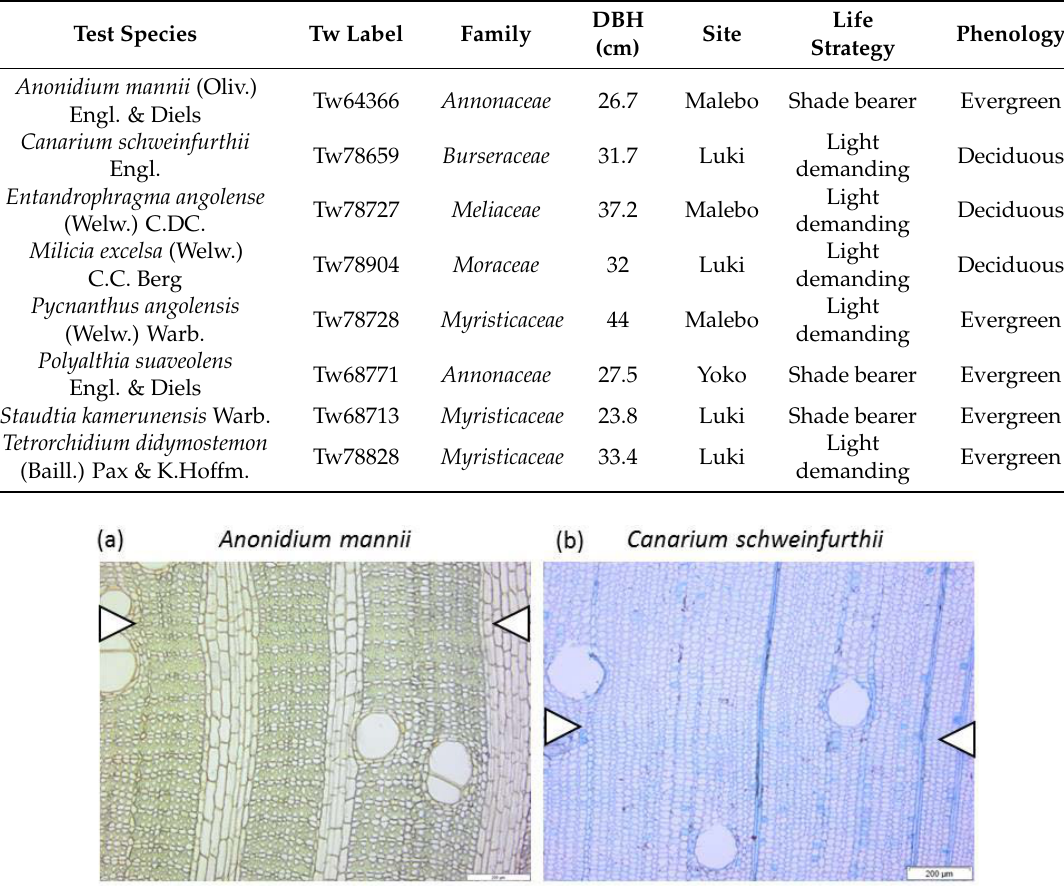
Table 1. Summary of the collected species that were used to link wood density to the tissue fractions. Diameter at breast height (DBH) of the sampled tree and Tervuren Wood identification number at the xylarium (Tw) is given as well. Life strategy and leaf phenology was extracted from [27]. Test Species